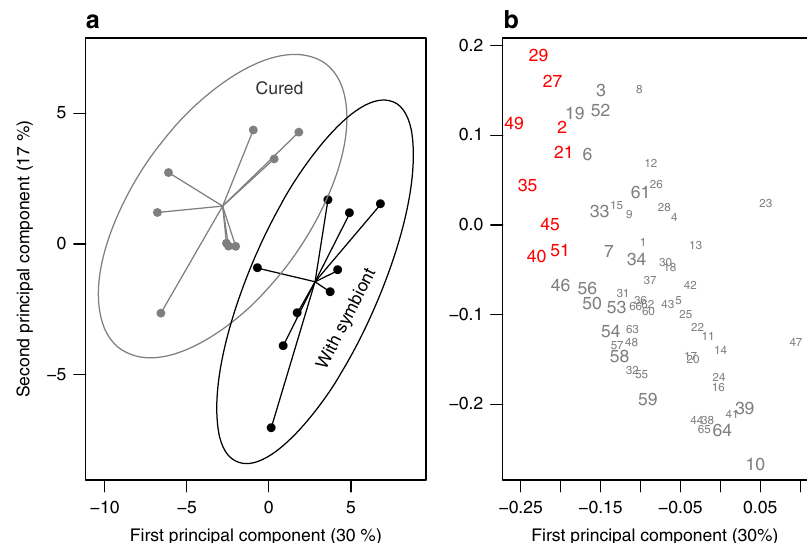
Fig. 3 Discriminant analysis of the volatiles collected in the plant headspace. Volatiles were collected from Vicia faba plants infested with Acyrthosiphon pisum aphids (strain 101) with or without the symbiont Hamiltonella defensa (antibiotic curing). a First two principal components of a PLS-DA plot. Each data point represents a plant, the centre of the star is the multivariate centroid, and the circle the 95% con fi dence interval. b PLS-DA loading plot with all compounds depicted with respect to the fi rst two principal components. Compounds depicted in a larger font have a variable importance in projection (VIP) score larger than 1, and those in red are emitted in a signi fi cantly larger amount by plants induced with symbiont-free aphids (Supplementary Table 2). In this fi gure some overlapping points were slightly displaced to increase clarity